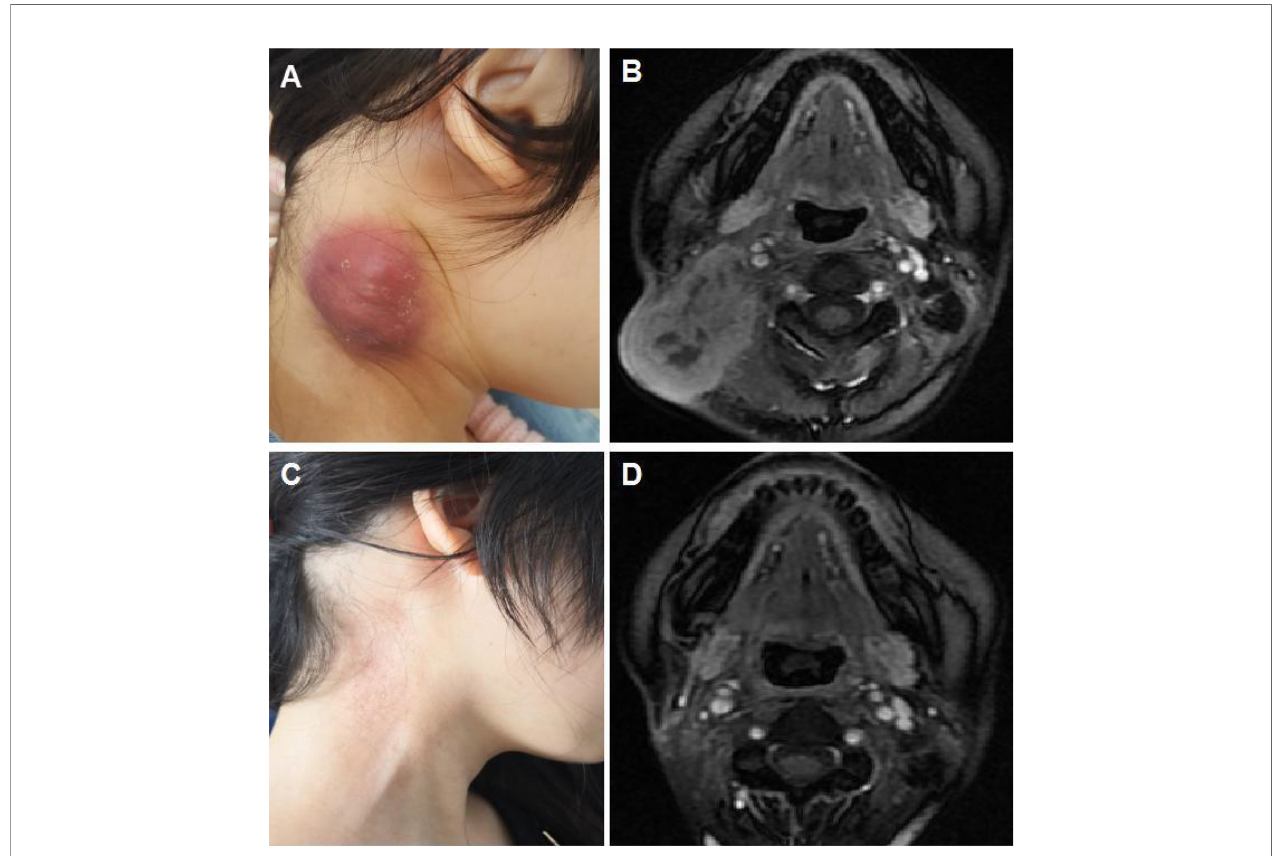
FIGURE 1 | Illustration of a typical recurrent nasopharyngeal carcinoma (NPC) case showing complete response after immune checkpoint inhibitor (ICI) treatment alone. (A) Baseline appearance of an 18-year-old girl with recurrent NPC who progressed after fi fth-line chemotherapy. (B) Baseline magnetic resonance imaging (MRI) demonstrating a large mass in the right neck. (C) Appearance of the 18-year-old girl after 4 cycles of ICI alone showing complete tumor response. (D) MRI illustrating the complete response of the mass in the right neck after 4 cycles of ICI alone.